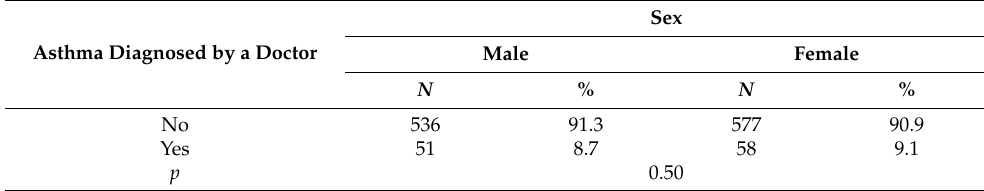
Table 2. Distribution by gender of the frequency of students who have asthma diagnosed by a doctor.